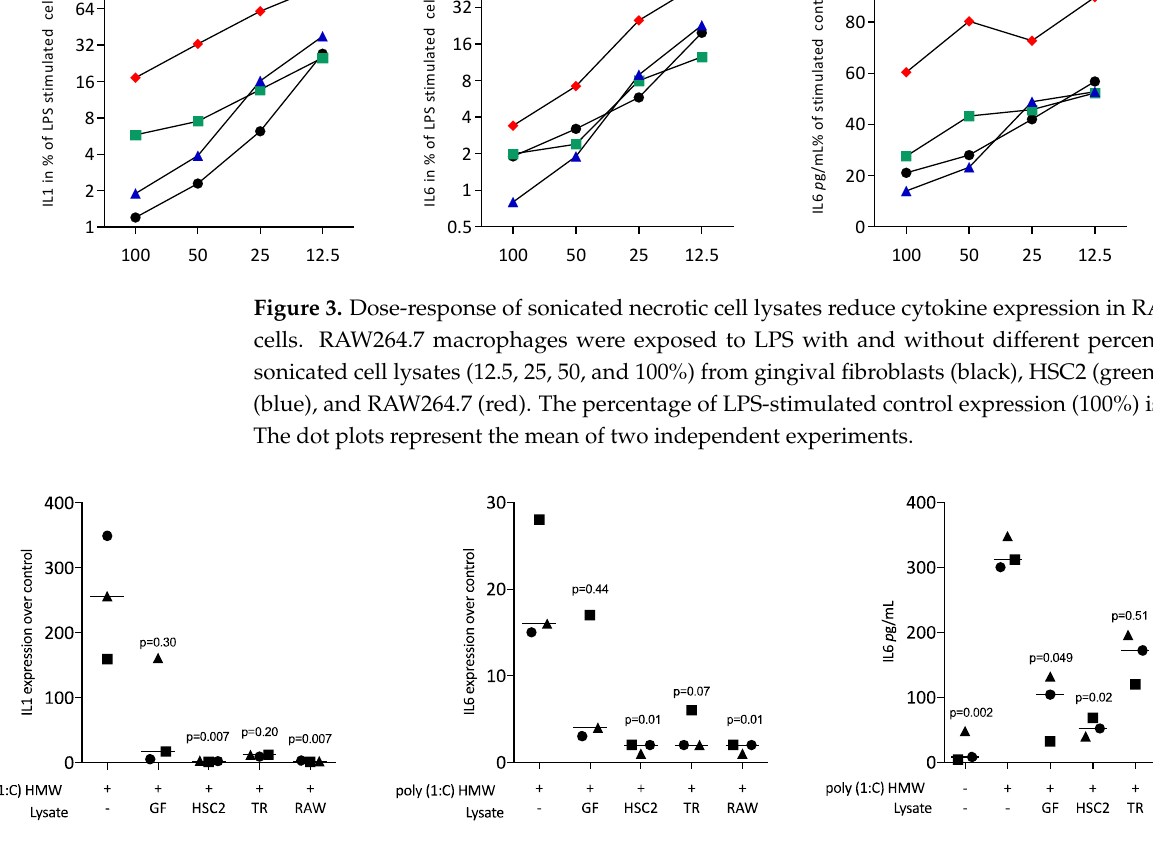
Figure 4. Sonicated necrotic cell lysates reduce TLR3 agonist-induced inflammation of RAW264.7 macrophages. RAW264.7 cells were exposed to necrotic cell lysates from gingival fibroblasts (GF), HSC2, TR146 (TR), and RAW264.7 (RAW) prepared by sonication in the presence of 10 µg/mL poly (1:C) HMW. The data show the x-fold changes in IL1 and IL6 gene expression and the release of IL6 protein into the supernatant. Data points indicate independent experiments. Statistical analysis was based on a Friedmann test and p -values are indicated.